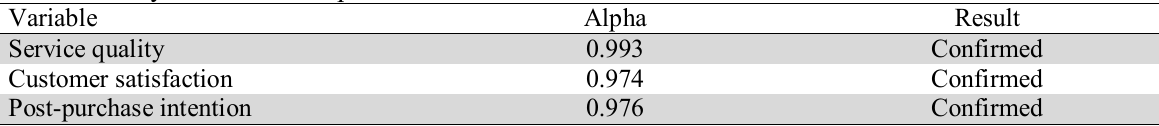
The summary of Cronbach